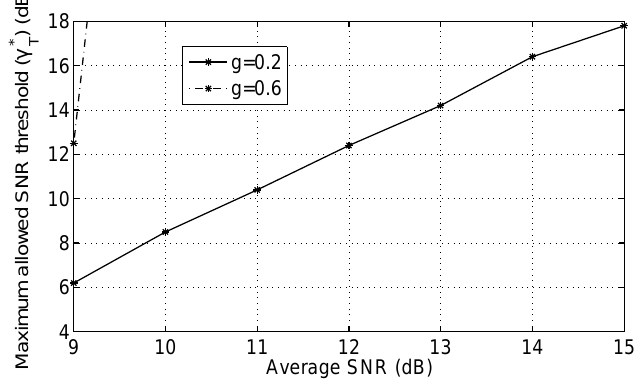
) as function of T